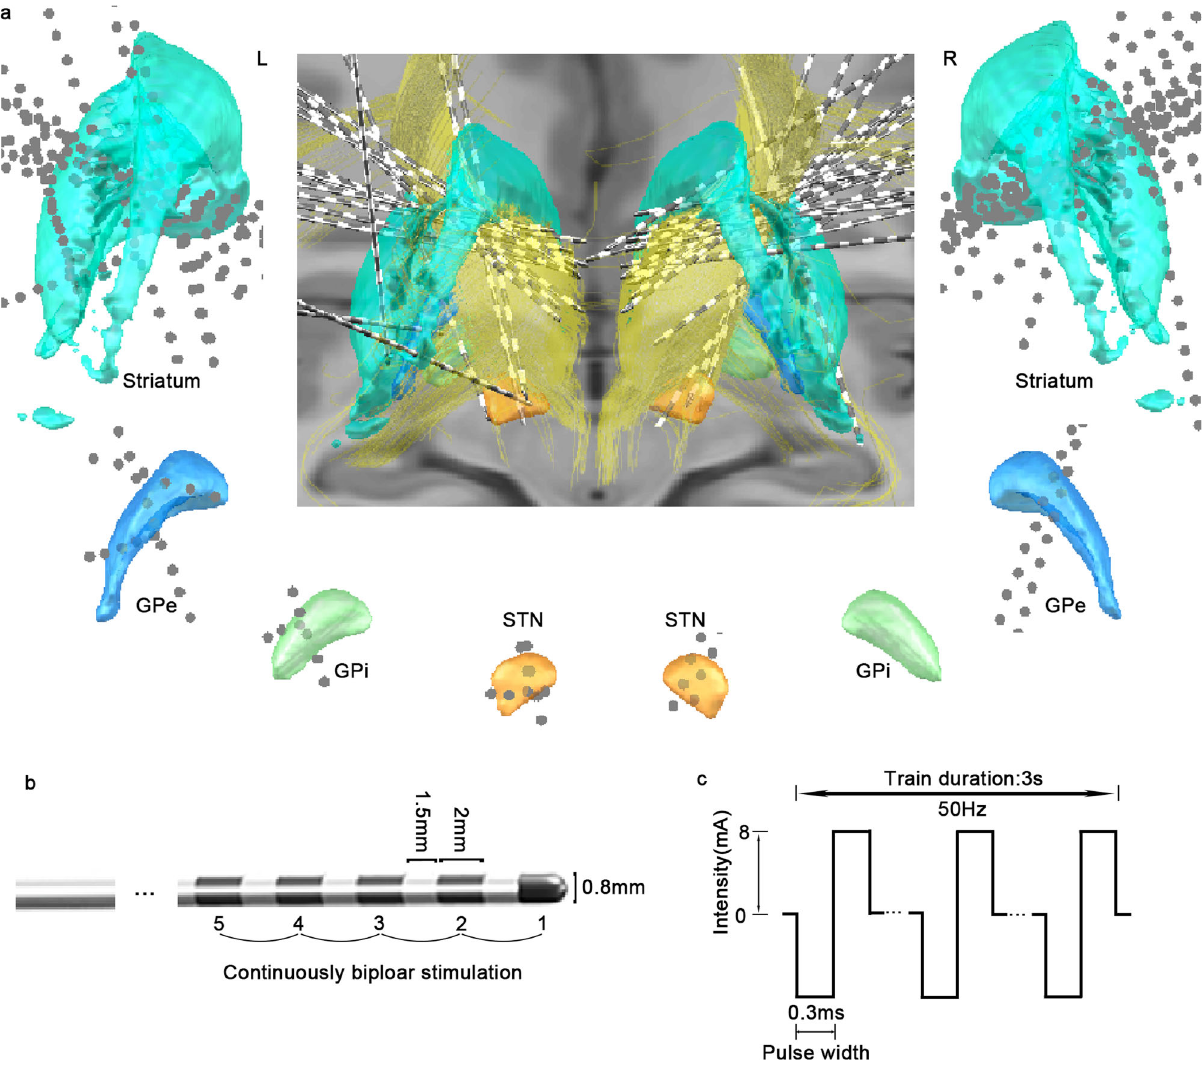
Fig. 1 Illustration of grouped electrodes passing through the BG in MNI space (ICBM 2009b), electrode con fi guration, and stimulus parameters. a 3D reconstruction of the multisite SEEG electrodes ( n = 42) passing through the BG (striatum in turquoise, GPe in blue, GPi in green, and STN in orange) as de fi ned by the DISTAL Atlas, together with the anterior limb of the internal capsule (yellow). The gray dots represent the sites of the SEEG electrodes. The electrodes passing through each BG subnucleus are illustrated. b SEEG electrode con fi guration used for stimulation. c Graphic illustration of the stimulus parameters using a rectangular biphasic pulse. MNI Montreal Neurological Institute, L left, R right, SEEG stereoelectroencephalography, BG basal ganglia, GPe external globus pallidus, GPi internal globus pallidus, STN subthalamic